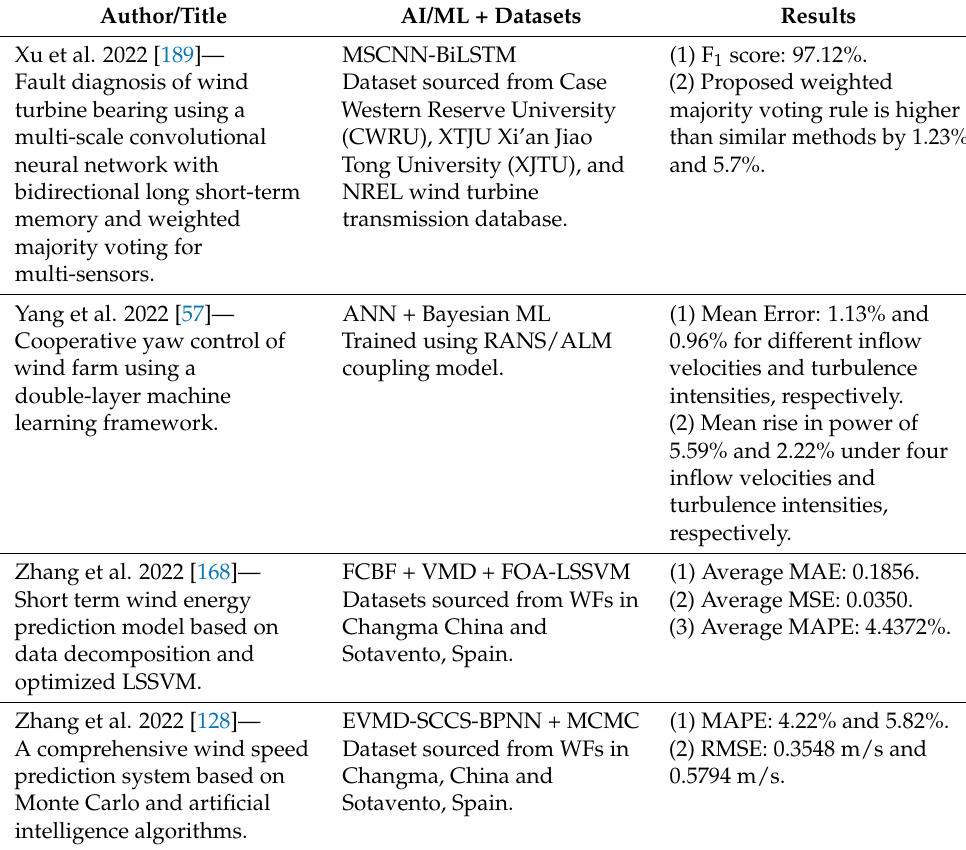
Table A2. AI and ML Algorithms for WF Control Systems